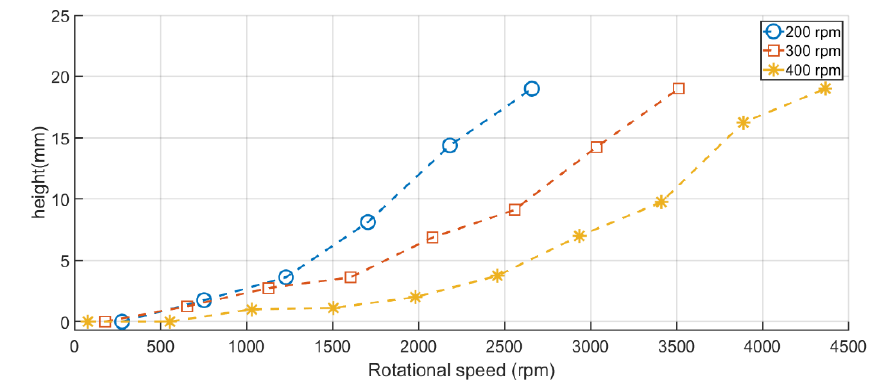
Figure 4. Experimental pump rotation speed vs. pumping balance points while the microfluidic CD is rotating at 200, 300, and 400 rpm.